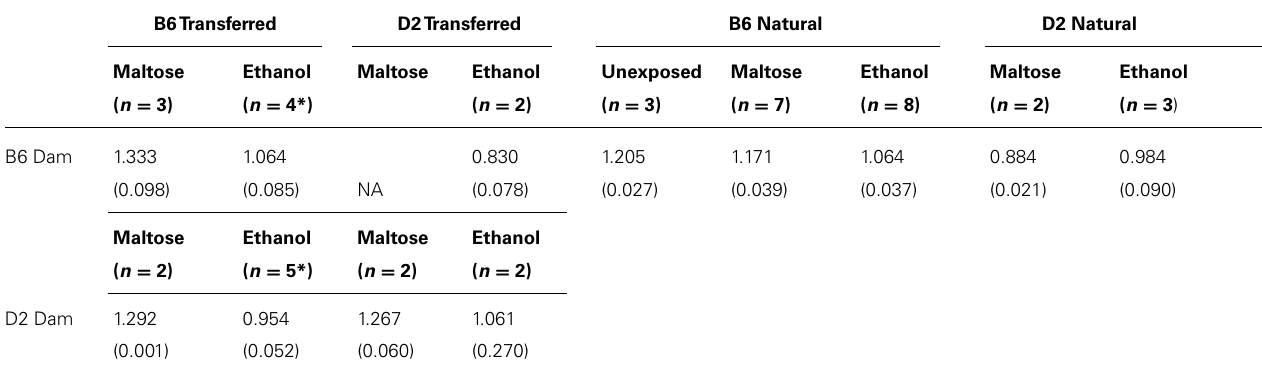
Table 3 | Mean litter weight in grams ( ± SEM).